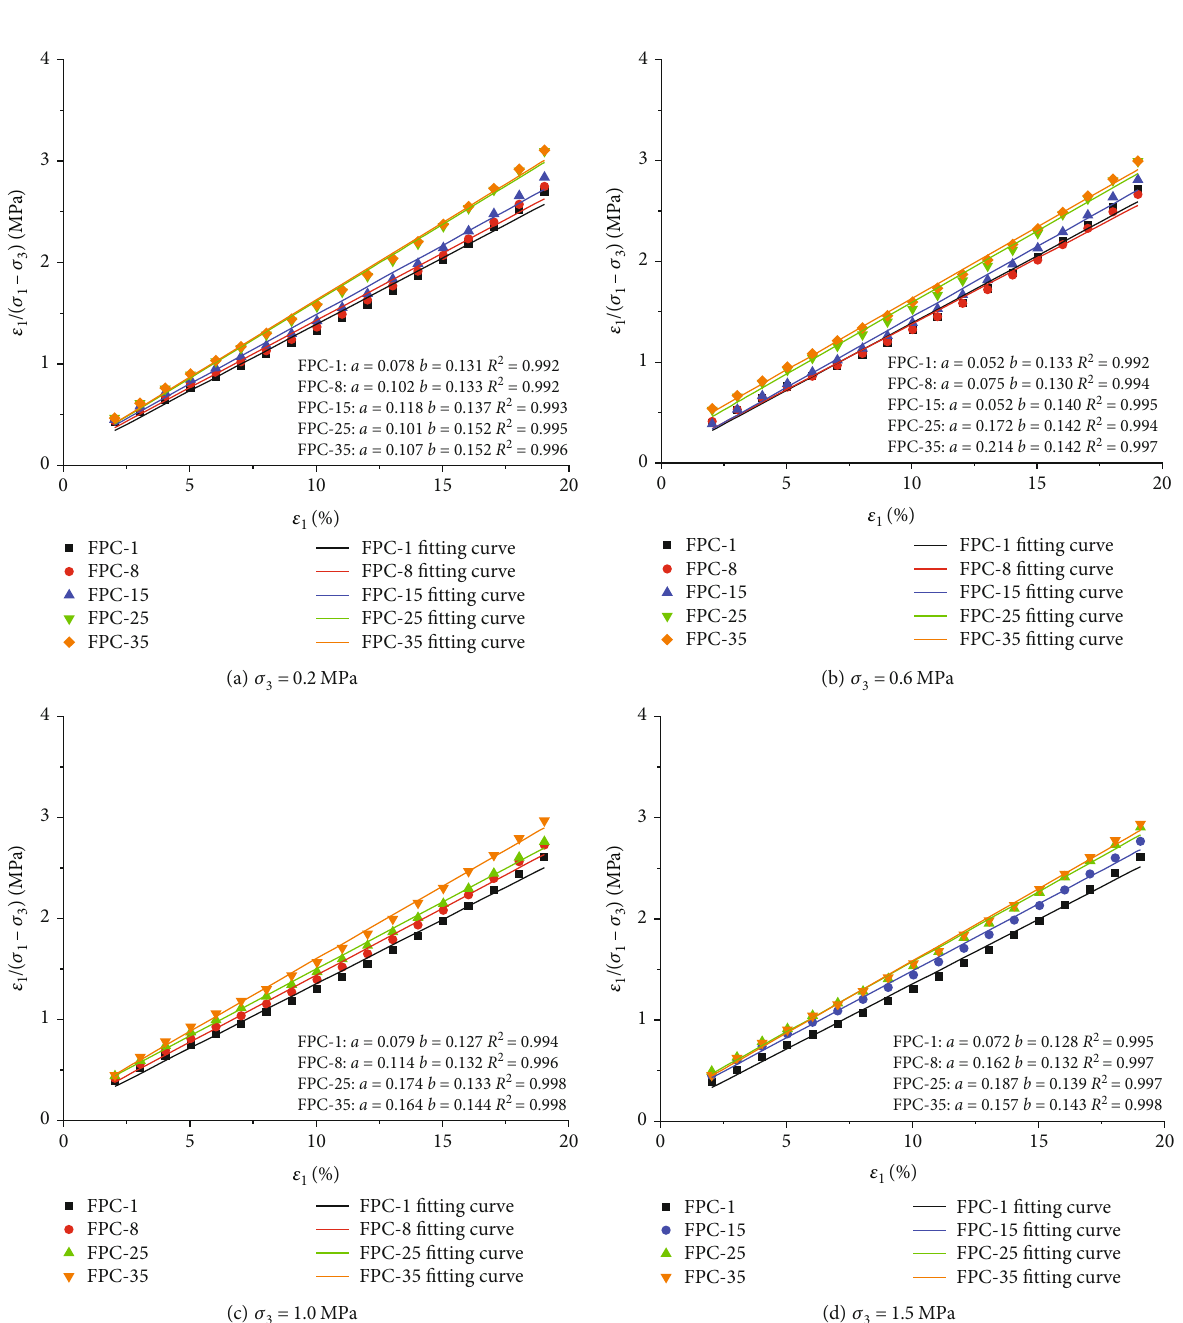
ff erent con fi ning